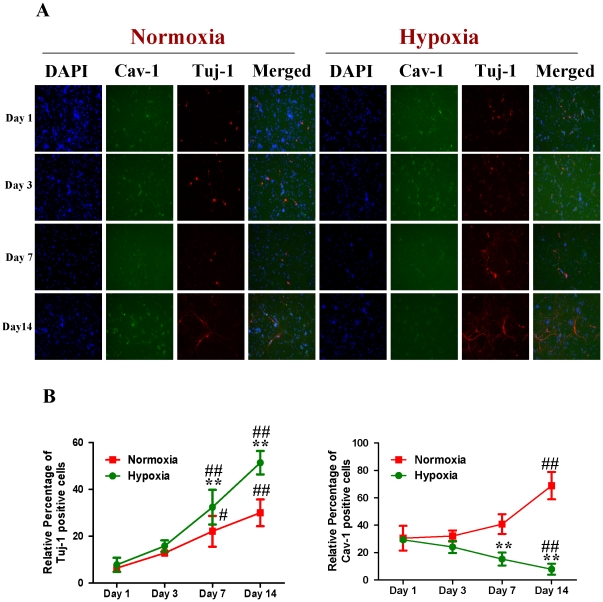
Dynamic changes of Cav-1 and differentiation of NPCs under normoxic and hypoxia-reoxygenation conditions.For hypoxia-reoxygenation (HR) treatment, NPCs were exposed 1% to O2 for 24 h and then switched to 21% O2 for 1, 3, 7, and 14 days, while for normoxic treatment, NPCs were consistently cultured under normoxia with 21% O2. Neuronal differentiation was identified by using Tublin β-III (Tuj-1). The fluorescent images were obtained with Carl Zeiss Axio Observer Z1 fluorescent imaging system. A. Representative immunofluorescent imaging of Tuj-1 and Cav-1 in NPCs: Red color: Tuj-1 staining; Green color: Cav-1 staining. Nuclear localization of Tuj-1 and Cav-1 was verified by co-localization with DAPI staining (blue color). B. Statistical analysis on the relative percentage of Cav-1 and Tuj-1 positive cells in NPCs (Mean ± S.D., n = 5). Hypoxia versus Normoxia at same time points, ** p<0.01; Observed day versus day 1 under the same oxygen condition, # p<0.05; ## p<0.01.